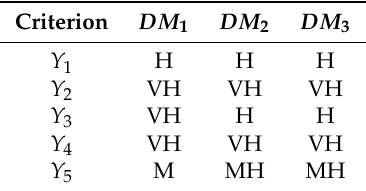
Table 3. Criteria weightage by decision-makers.